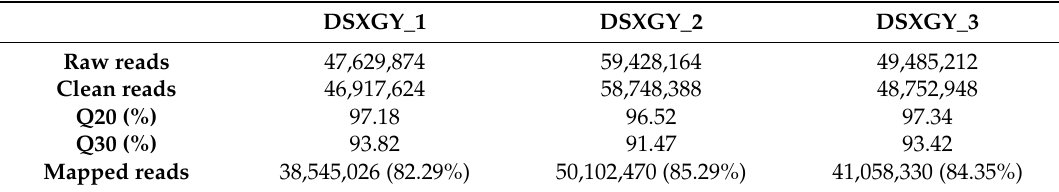
Table 1. RNA-seq data statistics.